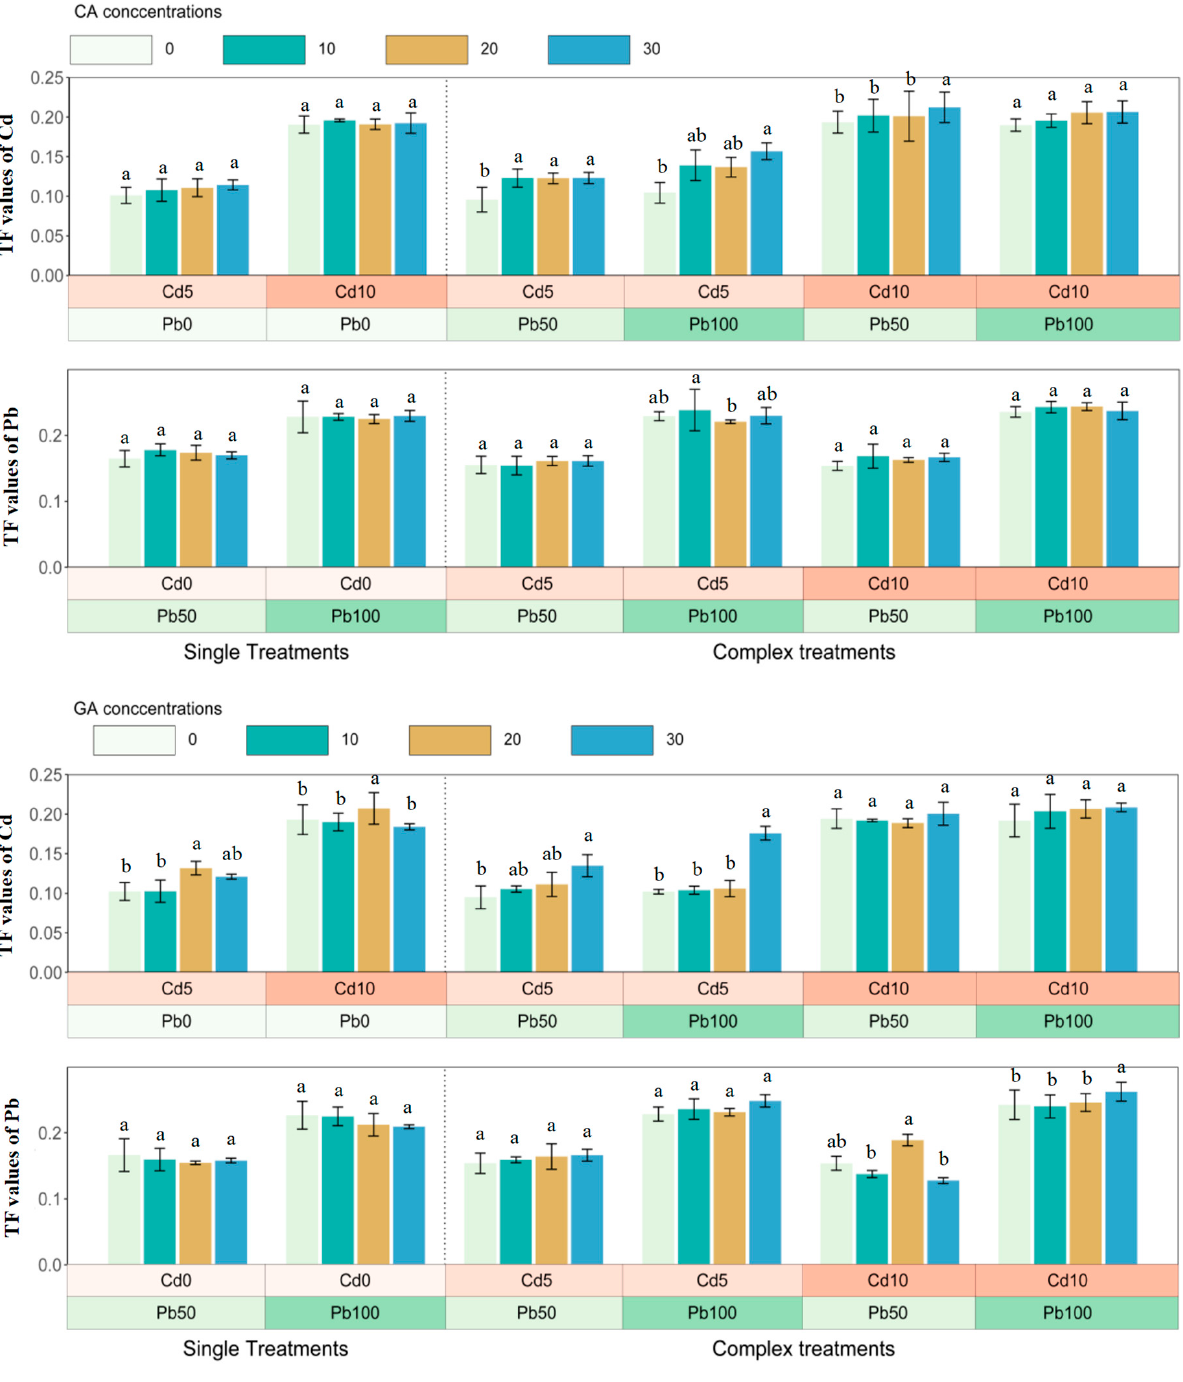
Figure 4. Translocation factors of Cd and Pb in sunflower with CA and GA addition, respectively, after 45 days. CA, citric acid; GA, glutaric acid; TF, transfer factor. Bars with different letters indicate significant difference at p < 0.05. Error bars represent ± SE.